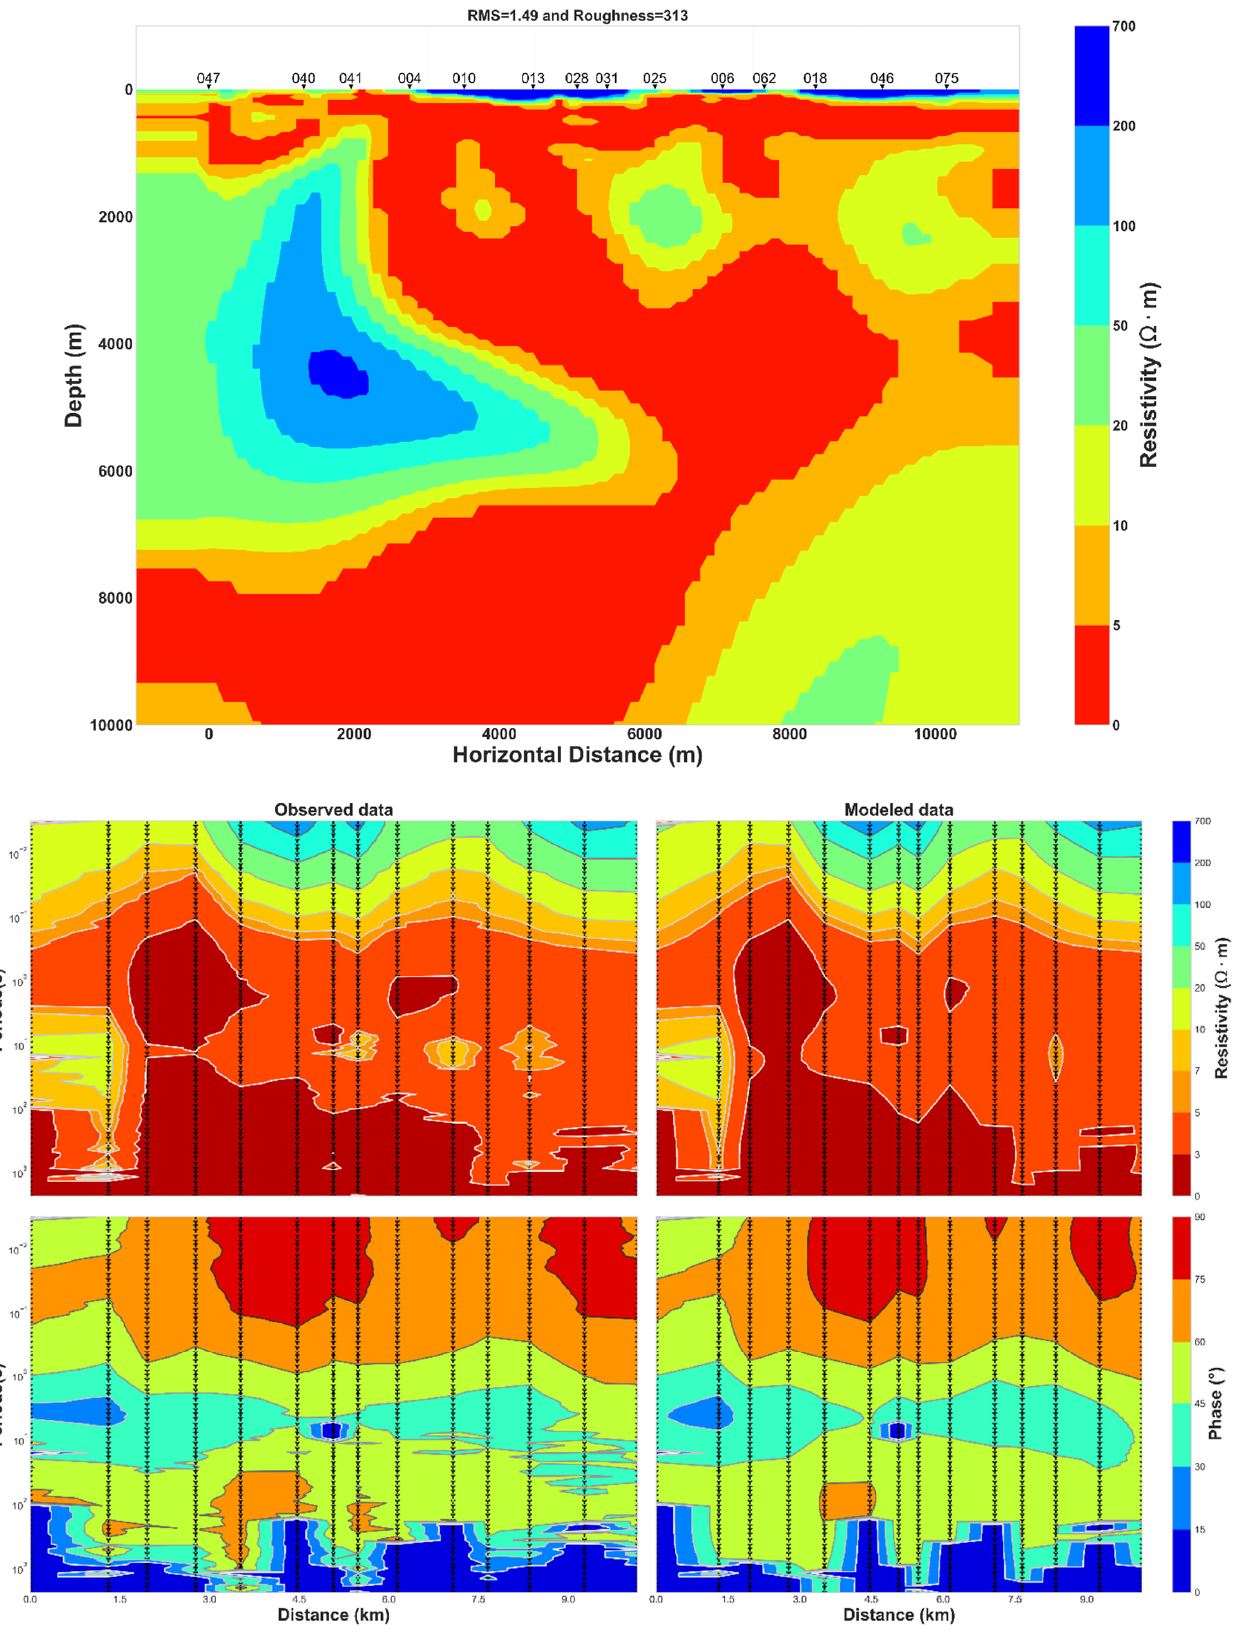
Figure A2. ( Above ) Joint Inversion model of TE and TM data for geoelectric strike of N120°E. ( Below ) Comparison between observed and modeled data.